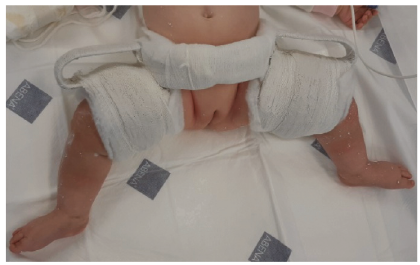
Figure 1: Hilgenreiner brace view from